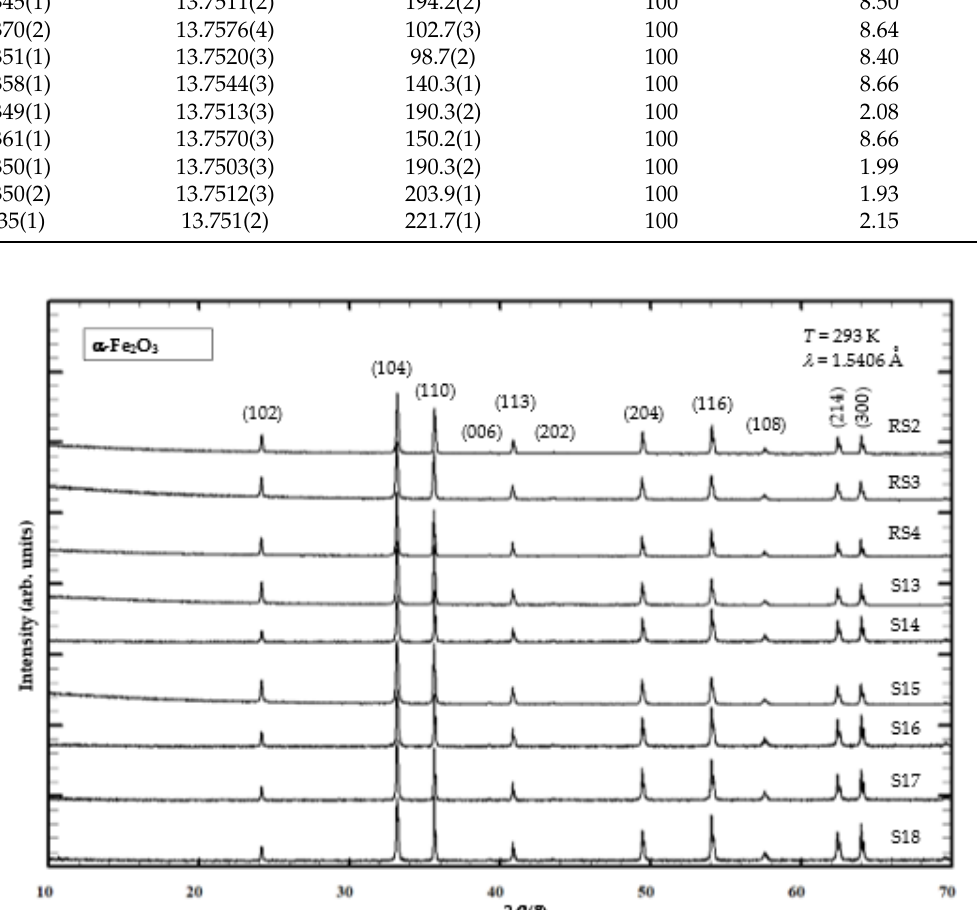
Figure 6. Cascade PXRD patterns of the reference samples RS2–RS4 and samples S13–S18 prepared at 260 °C.